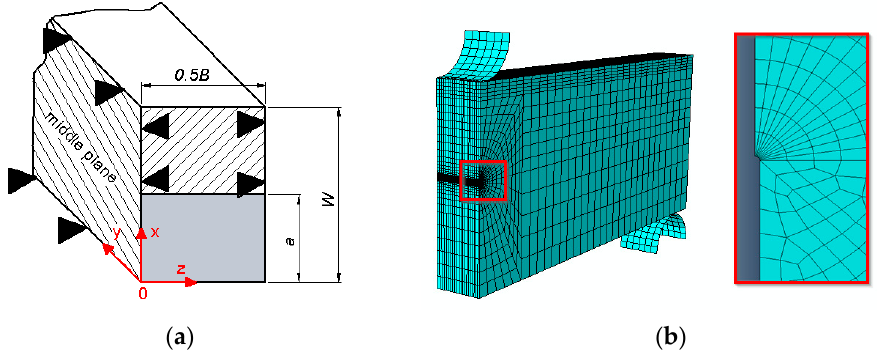
Figure 11. Numerical model of SENB specimen: ( a ) scheme of the boundary conditions; ( b ) scheme of the mesh.